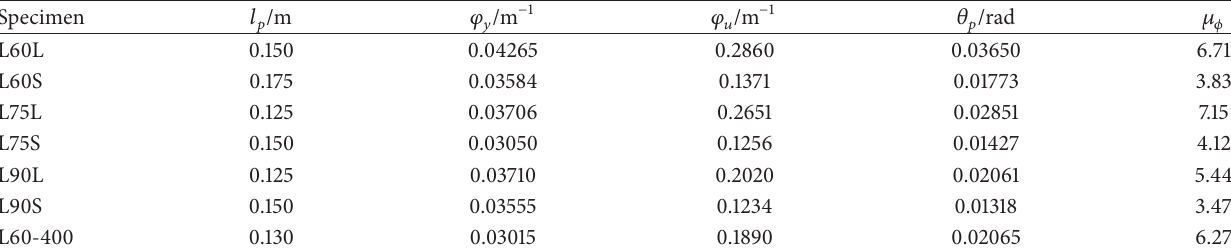
Table 5: Curvature ductility of L-shaped